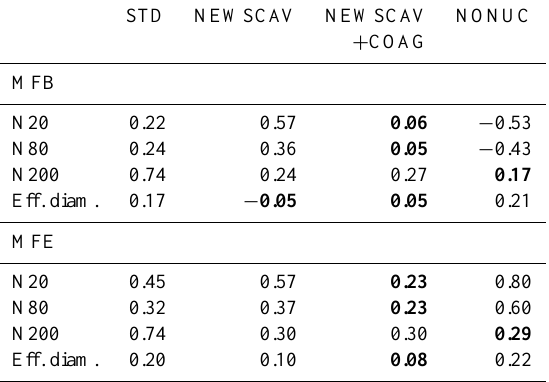
Figure 5. Monthly median number concentration for aerosols with diameters of 20–500nm (N20), 80–500nm (N80), and 200–500nm (N200) and effective diameter from the 2011–2013 Alert SMPS measurements and for the four GEOS-Chem-TOMAS dry size dis- tribution simulations described in Table 1. The measurement 20– 80th percentile is in grey shading. Simulations are shown in colour as indicated by legend. Table 4. Model–measurement mean fractional bias and mean frac- tional error (Eqs. 7 and 8) for N20, N80, N200, and effective diam- eter at Alert (in reference to Fig. 5). Bias and error values closest to zero for each season are highlighted in bold.